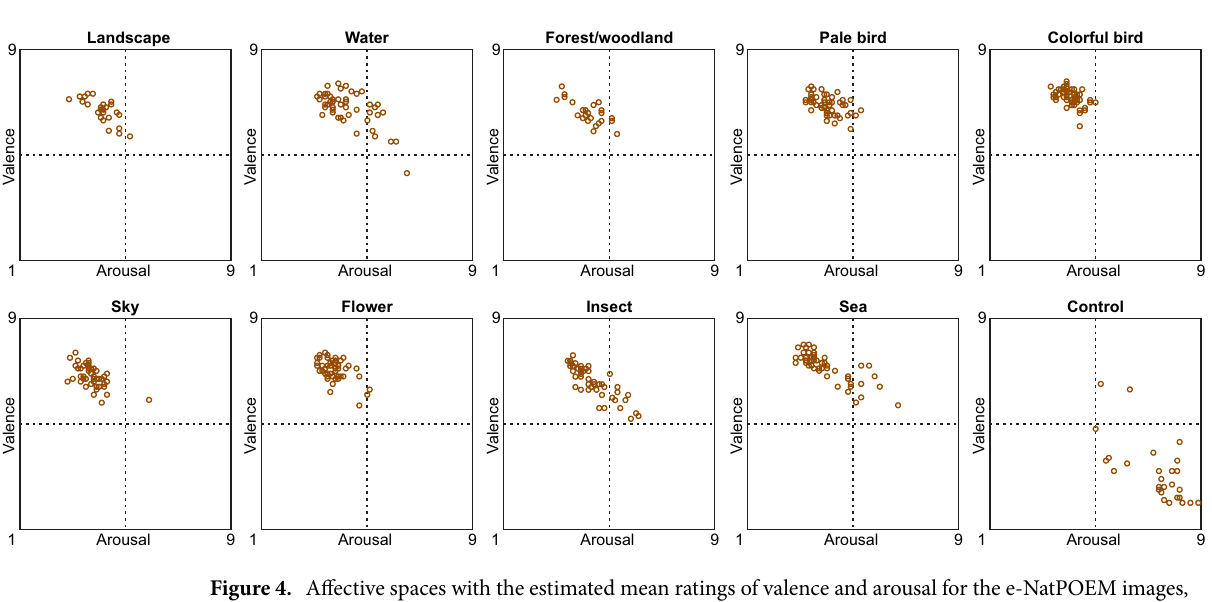
Figure 4. Affective spaces with the estimated mean ratings of valence and arousal for the e-NatPOEM images, by